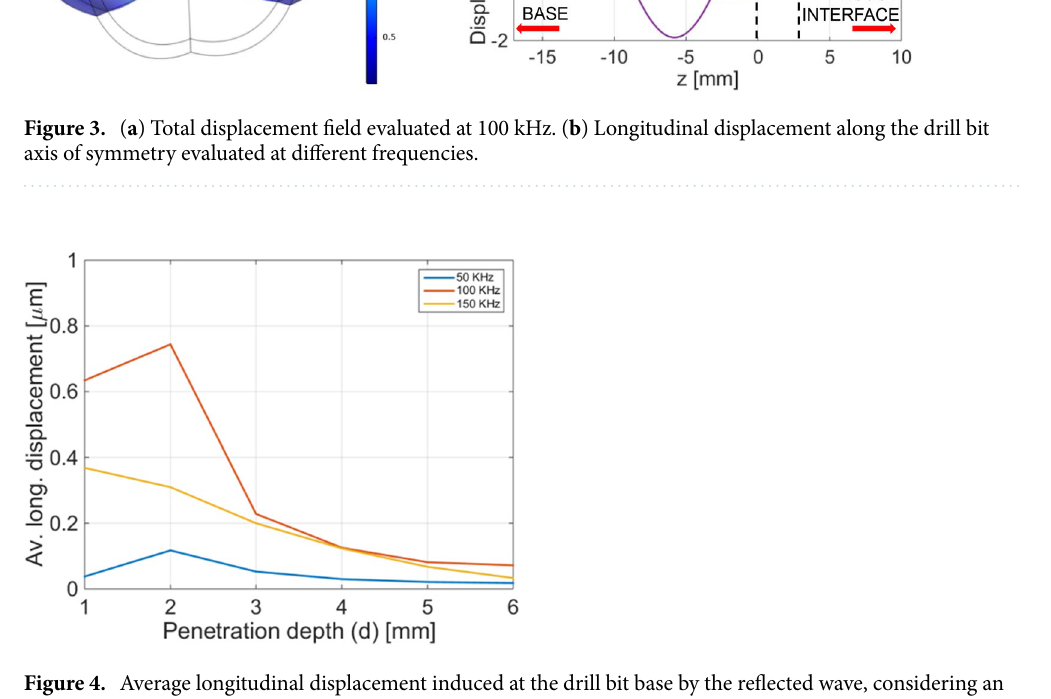
Figure 4. Average longitudinal displacement induced at the drill bit base by the reflected wave, considering an input displacement of